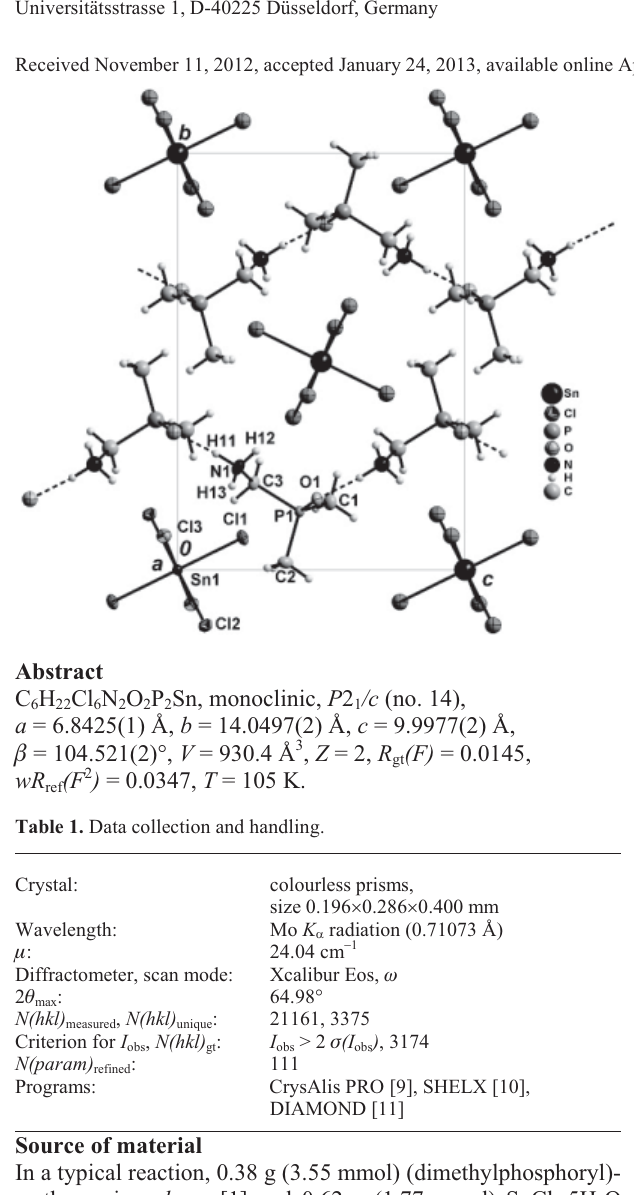
(Fig.1.; first level graph set descriptor: C 1 1 (5) [7]). These chains